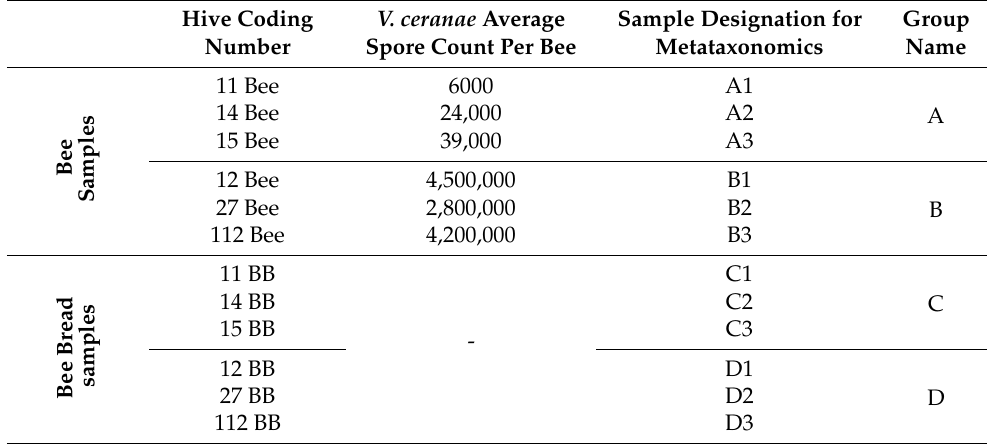
Table 1. Hive coding number, V. ceranae average spore count per bee and sample designation and grouping for